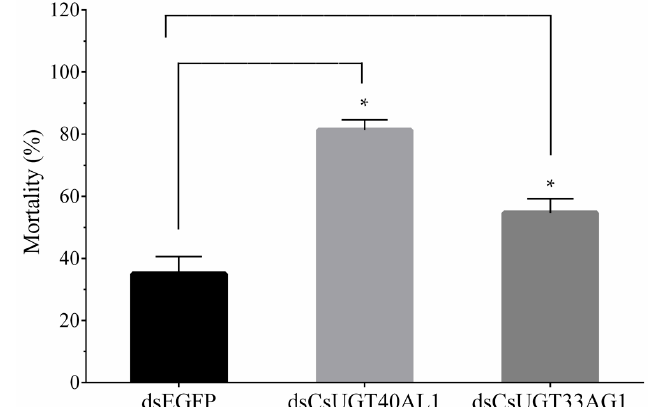
Figure 6. Mortality of chlorantraniliprole-treated YYR strain of C. suppressalis larvae after individual dsRNA injection. Error bars represent the SD from the mean of three independent replicates. For each biological replicate, 30 fourth instar larvae were sampled. Asterisks (*) indicate significant differences between treatments as determined by Student’s t -test ( p < 0.05).